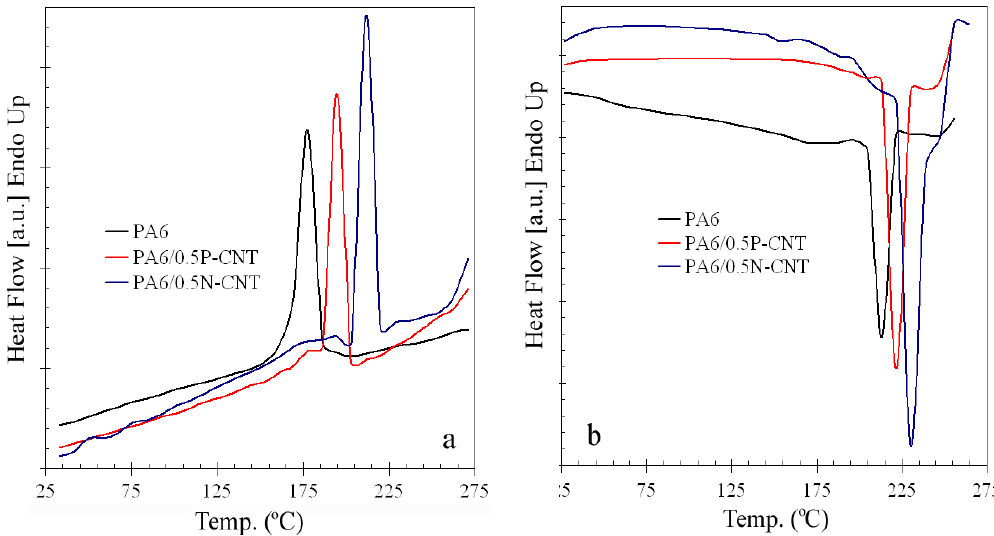
Figure 6. ( a ) Crystallization thermograms and ( b ) melting thermograms for neat and composite PA6 samples at a rate of 10